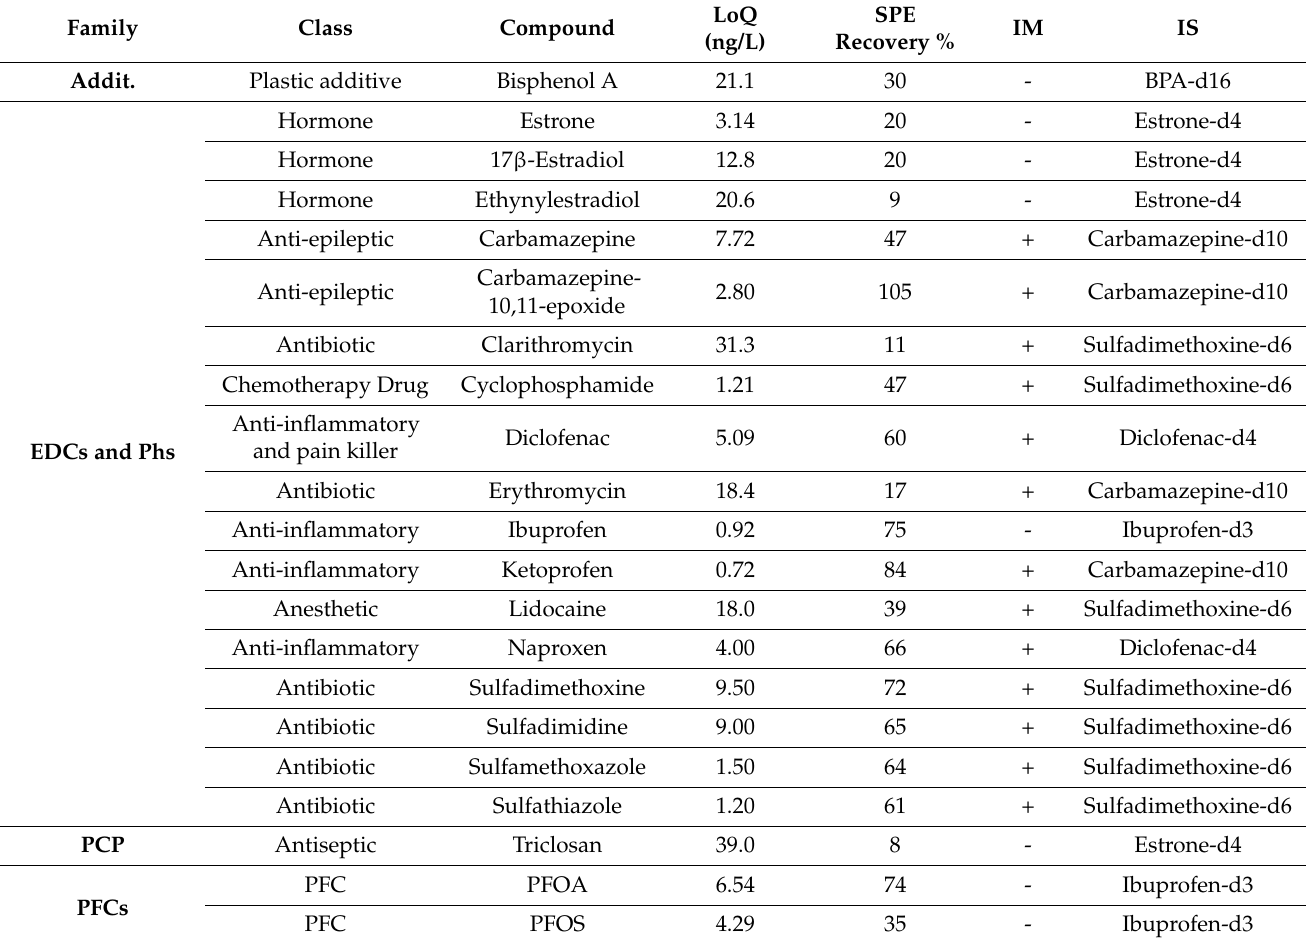
Table 2. List of the studied micropollutants, classification, limit of quantification (LoQ), SPE recovery in percentage (%), ionization mode (IM), and internal standards (IS). ‘Addit.’ corresponds to additives, EDCs corresponds to endocrine disruptors, Phs to pharmaceuticals, PCP to personal care products, and PFCs to perfluorinated